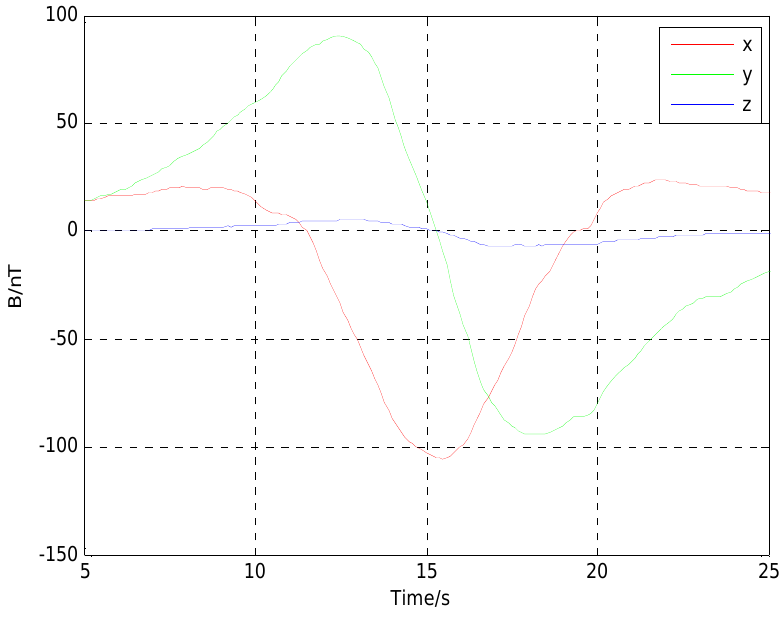
Figure 13. Amplitude curve of three component magnetic field data.